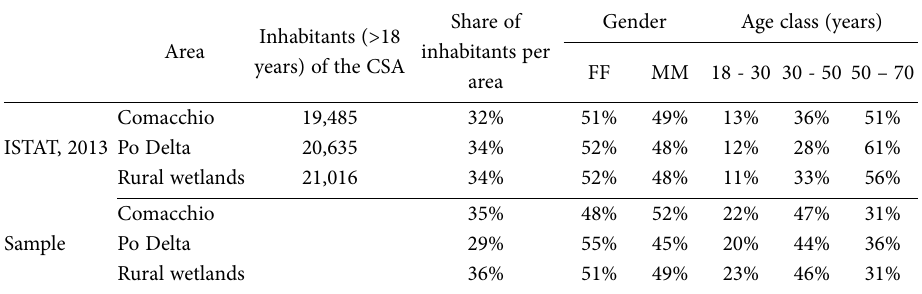
Table 2. Demographic features of the CSA (ISTAT, 2013) and sample description according to the three stratification levels: residency area, gender and age class. Response rate of the survey was